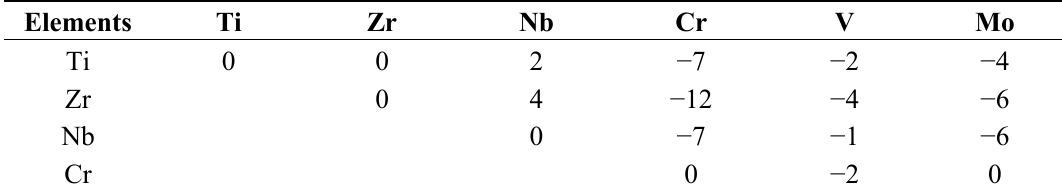
AB H  ) of a pair of mix